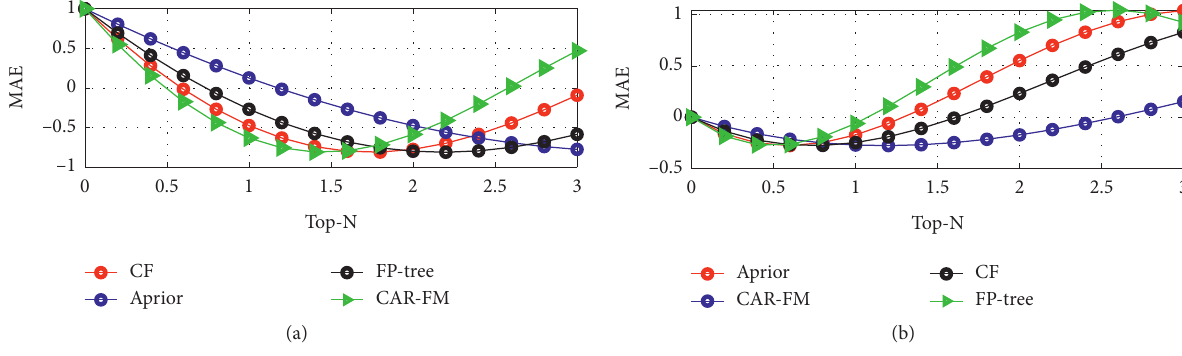
Figure 6: Comparison of accuracy rate and mean absolute error of the digital art feature matching